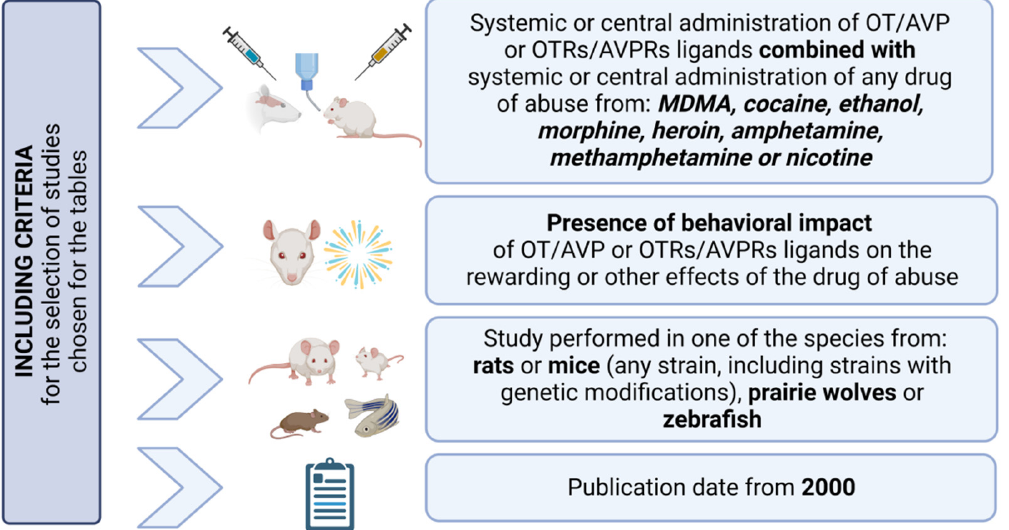
Figure 2. Including criteria for the selection of studies chosen for the Tables 1–4. This figure was created with https://biorender.com/ (accessed on 10 January 2023).